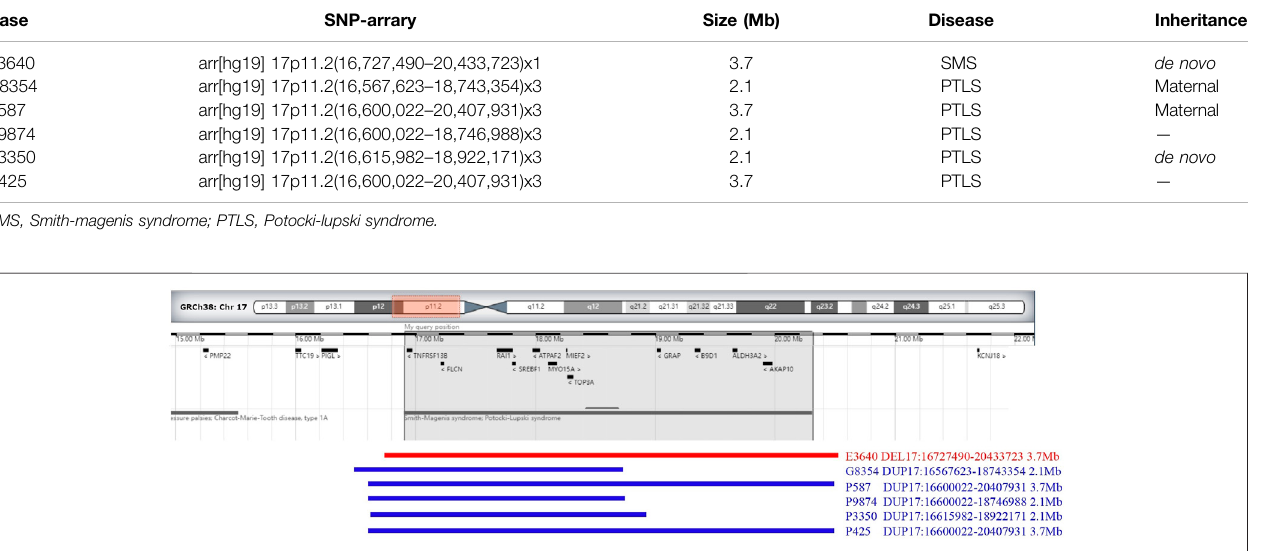
TABLE 2 | Results of SNP-array in six fetuses.